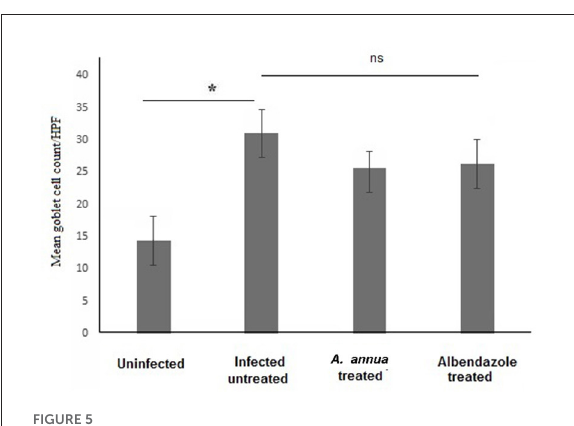
cells (black arrows) in infected untreated animals (Figure 6B).